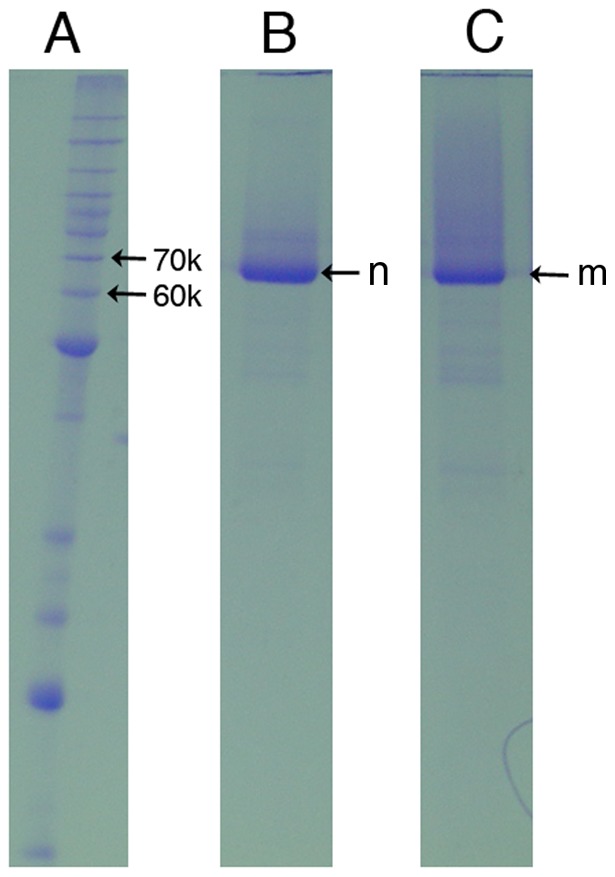
Electrophoretic analysis (SDS-PAGE) of the purified rAgAChE (WT and G119S).A: Protein standard (Da); B: rAgAChE-WT (“n”); C: rAgAChE-G119S mutant (“m”).